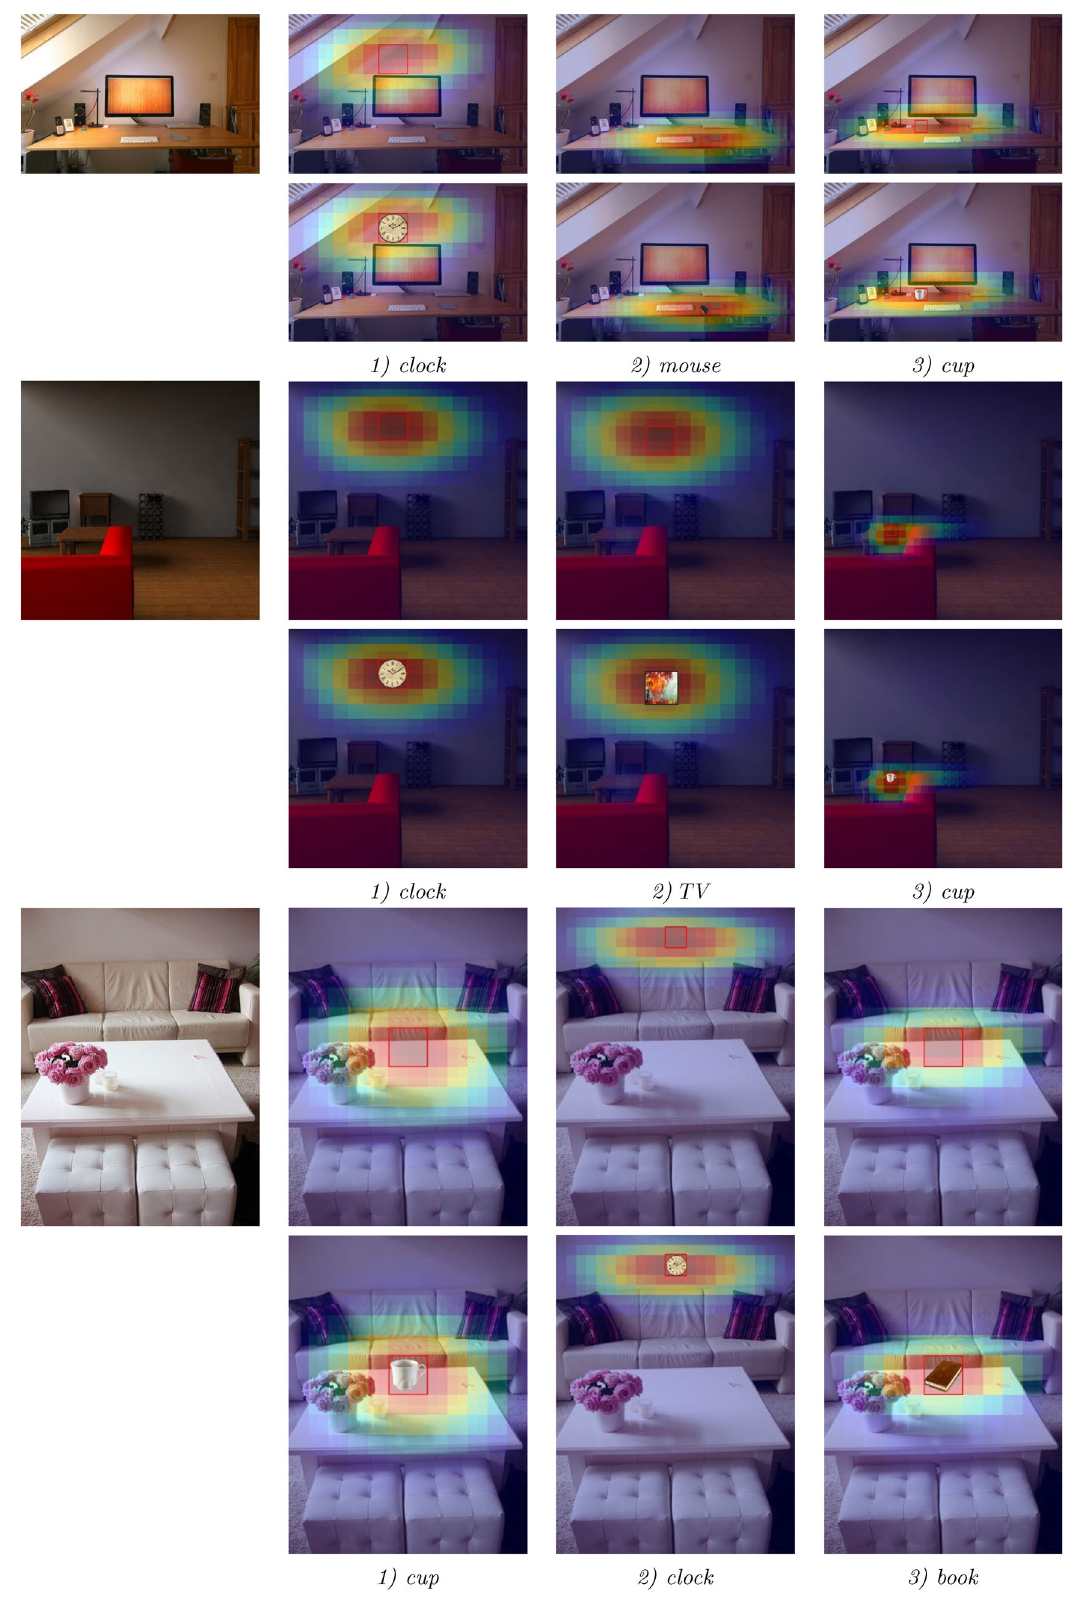
Fig. 2 Object recommendation results. Each case shows, in the top row, the recommended bounding box and indicative heatmap automatically generated for the top 3 recommended object categories. The second row is generated using manually selected but automatically pasted object segments (as a basis for comparison